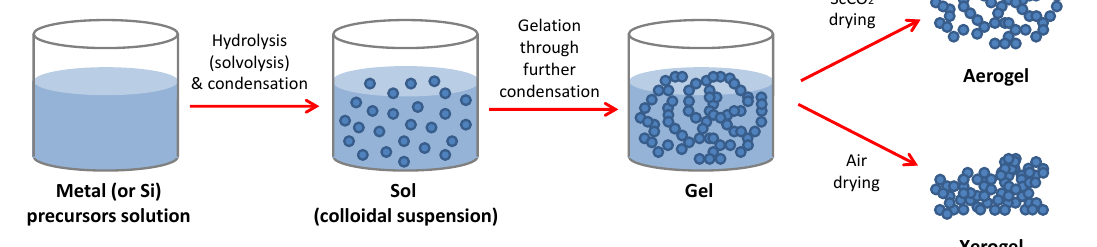
Figure 1. General scheme of a sol-gel synthesis method.